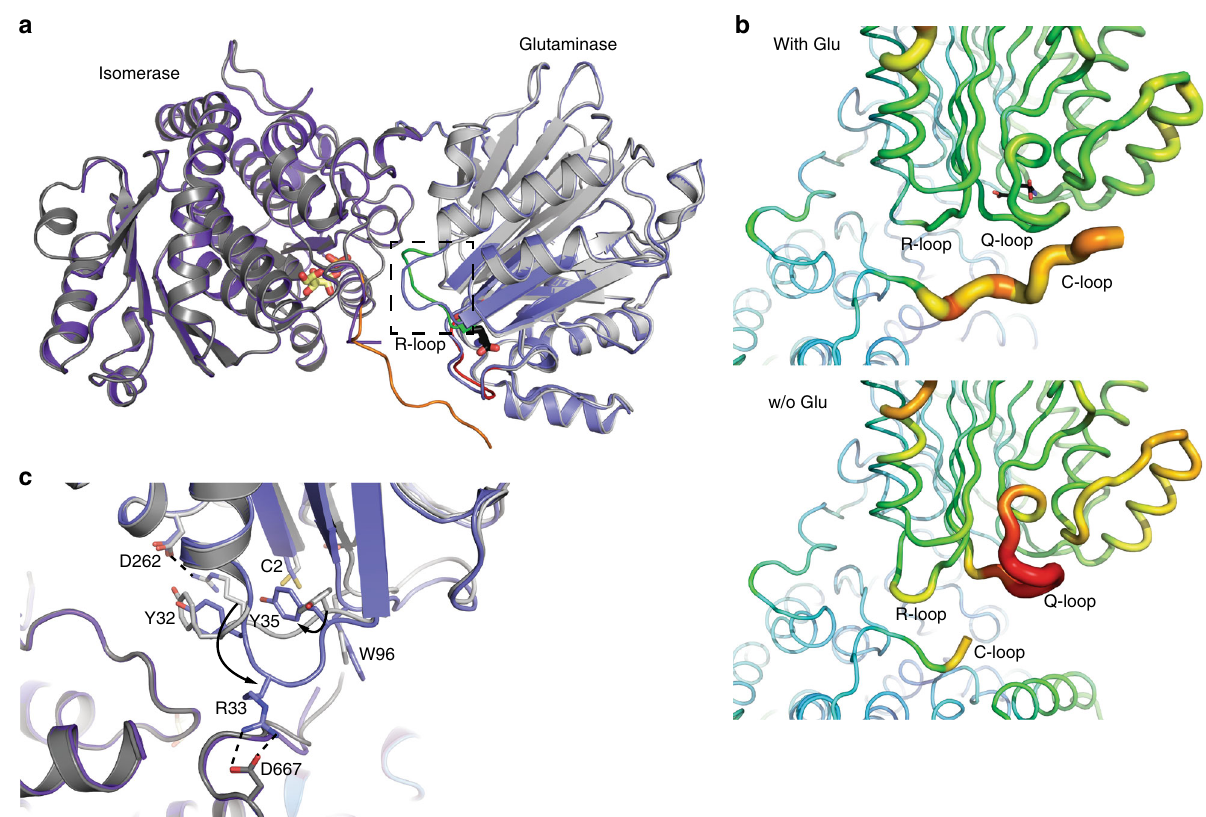
Fig. 3 Glutamate determines conformation of Q-loop, R-loop, and C-loop. a , c Superposition of Glu-free and Glu-bound GFAT-1 monomer A. Proteins are presented as cartoons. Glu-bound GFAT-1 is depicted in gray and Glu-free GFAT-1 is colored in purple. Glc6P (yellow sticks) and L -Glu (black sticks) are highlighted, as well as important loops: R-loop (green), Q-loop (red), and C-loop (orange). a Overview. Glutamate presence/absence in fl uences the conformation of the R-loop (black box). b Representation of B-factors in Glu-bound (upper) and Glu-free (lower) wild type human GFAT-1 as putty cartoon. Colored from low to high values (20 – 200 Å 2 , blue to red). L -Glu (black sticks) is highlighted. Glutamate absence destabilizes the Q-loop. c Glutamate absence induces R-loop fl ipping with large movements of side chains of R33 and